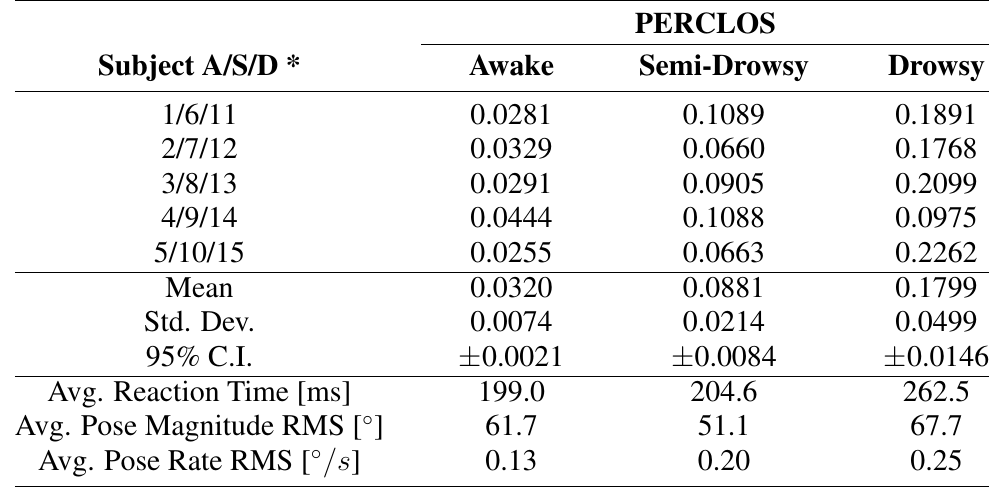
Table 2. PERCLOS average, standard deviation, 95% confidence interval for the different subjects (1–5 awake, 6–10 semi-drowsy and 11–15 drowsy) and reaction time, pose and pose rate-of-change for the ensemble of awake, semi-drowsy and drowsy